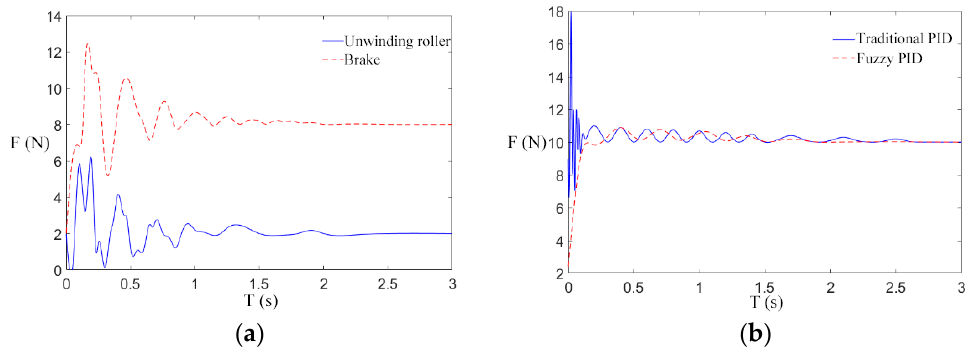
Figure 12. Tension response at 10 N reference tension. ( a ) Tension of unwinding roller and electro- magnetic brake; ( b ) Tension of take-up roll.